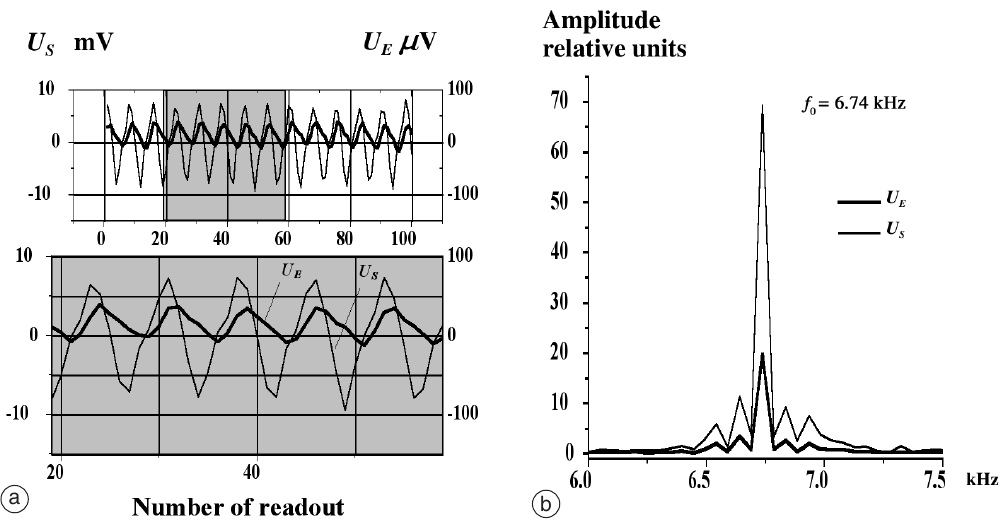
Fig. 5a,b. MSO of the first type ( E = 0): a) electric ( U E ) and acoustic ( U S ) signals; b) spectra of the signals U E and U S